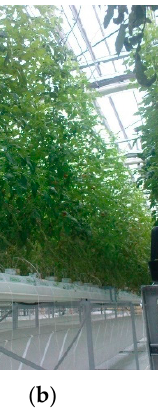
Figure 2. Tomato production in soilless culture with rockwool as a growing medium: ( a ) Transplants in rockwool cubes, shortly before the start of greenhouse cultivation; ( b ) tomato plants in rockwool slabs (photos: Gruda, private collection).